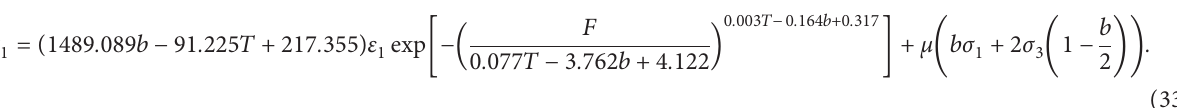
Figure 8: Theoretical and experimental curves of the true triaxial tests with varying b values. (a) − 5 ° C. (b) − 10 ° C. (c) − 15 °